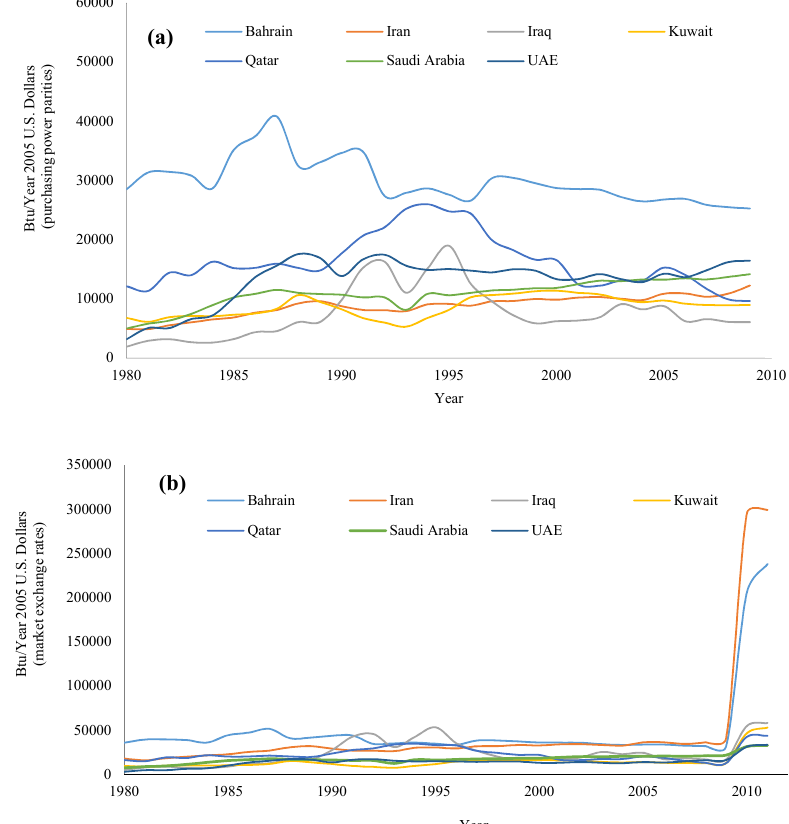
Fig. 1: Energy Intensity–Total primary energy consumption/Dollar of GDP for the Persian Gulf States (a) Purchasing power parities (b) Market exchange rates